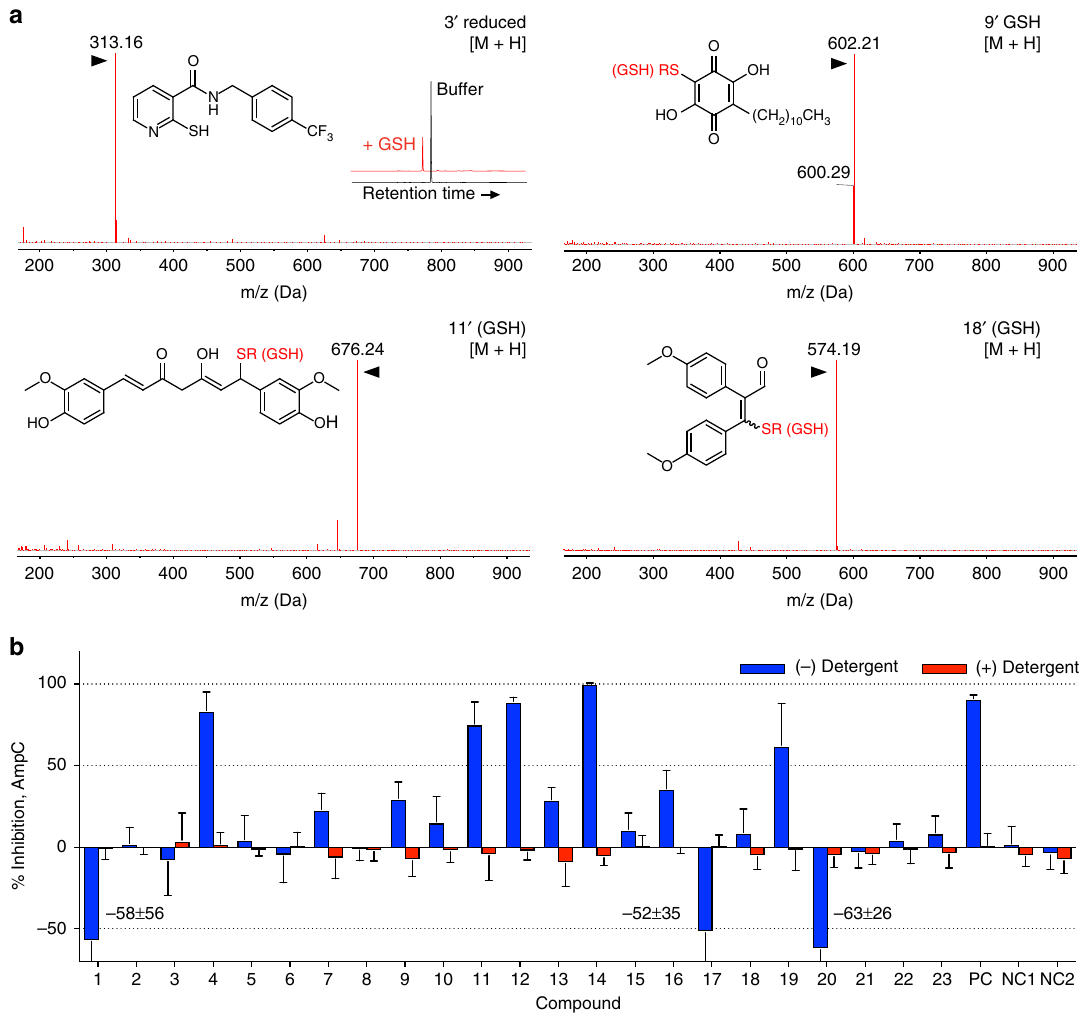
Fig. 2 Reported HAT inhibitors exhibit common mechanisms of assay interference. a Several reported HAT inhibitors form adducts with GSH (denoted by apostrophe) in vitro as detected by UPLC-MS. Note for compound 3 , the parent compound and the compound detected after treatment with CoA elute at different retention times (see inset). Data are representative results from at least two independent experiments. R, GSH. b Several reported HAT inhibitors are positive in an aggregation counter-screen. Compounds were tested for AmpC β -lactamase inhibition ± Triton X-100. Rottlerin, lidocaine, and fl uconazole were included as positive control (PC) and negative control (NC1, NC2) compounds, respectively. Data are expressed as mean ± SD pooled from three or four independent experiments each performed with three technical replicates. See Table 1 for additional results and